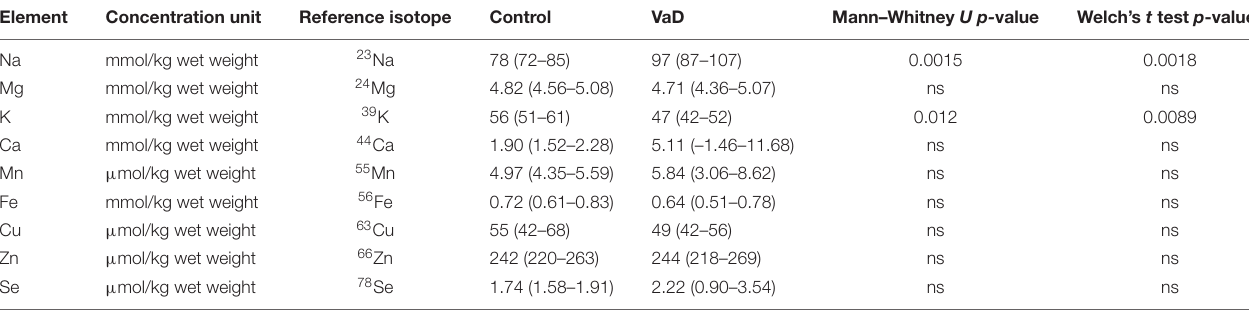
TABLE 2 | Wet-weight metal concentrations in hippocampus of VaD and control brains.